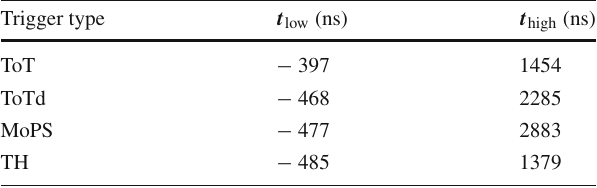
Table 1 Temporal window limits t low and t high used to remove stations from an event, for each station-level trigger algorithm